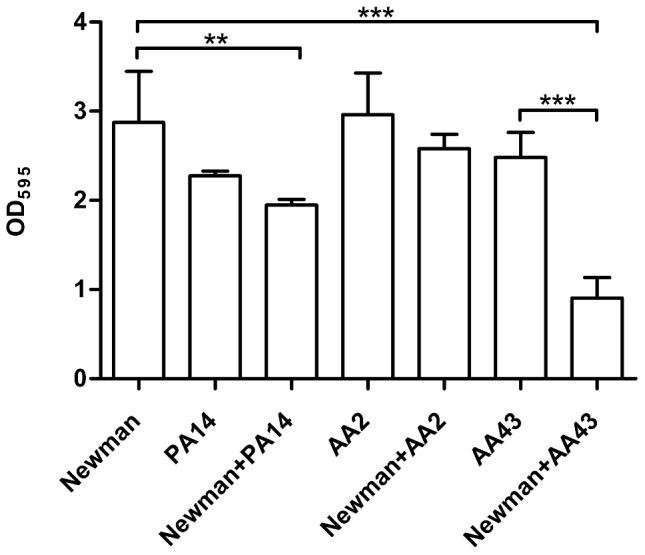
Biofilm formation by S. aureus and P. aeruginosa strains in single and dual cultures.Bacteria were grown overnight in 96-well flat-bottom microtiter plates in NB medium at 37°C either individually cultured or co-cultured at a 1∶1 ratio. Biofilm biomass was quantified by staining with crystal violet and absorbance measurements at OD 595 nm. The values represent the means of three independent experiments, and the bars indicate standard deviation. Statistically significant differences in Student's t test are indicated by symbols when present: **: p<0.01; ***: p<0.001.